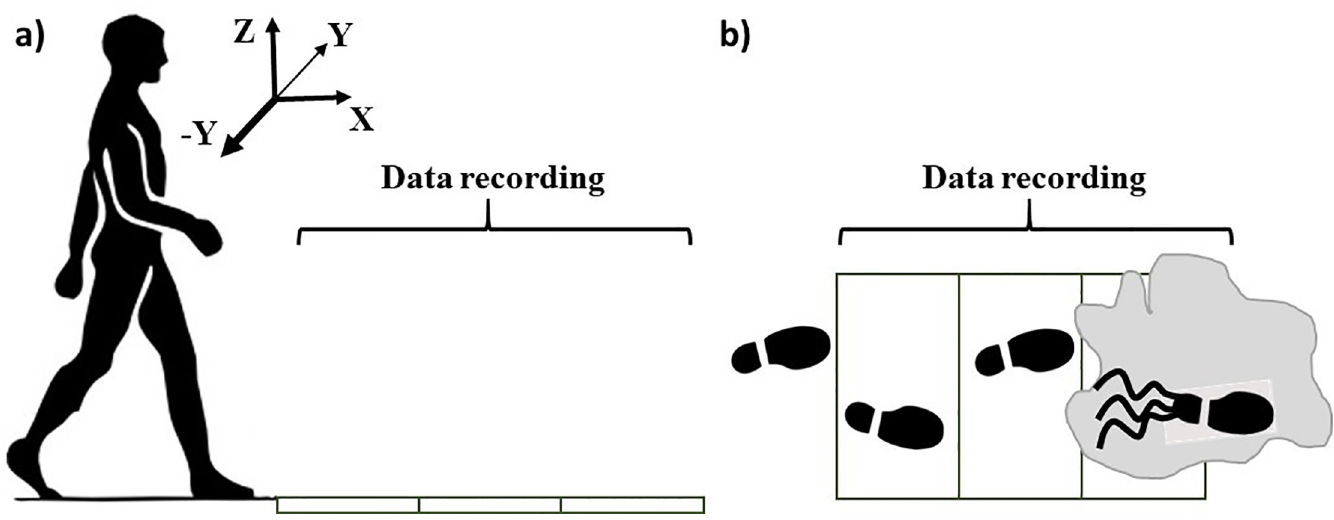
Fig 1. Experimental setup, contamination, and foot placing during the